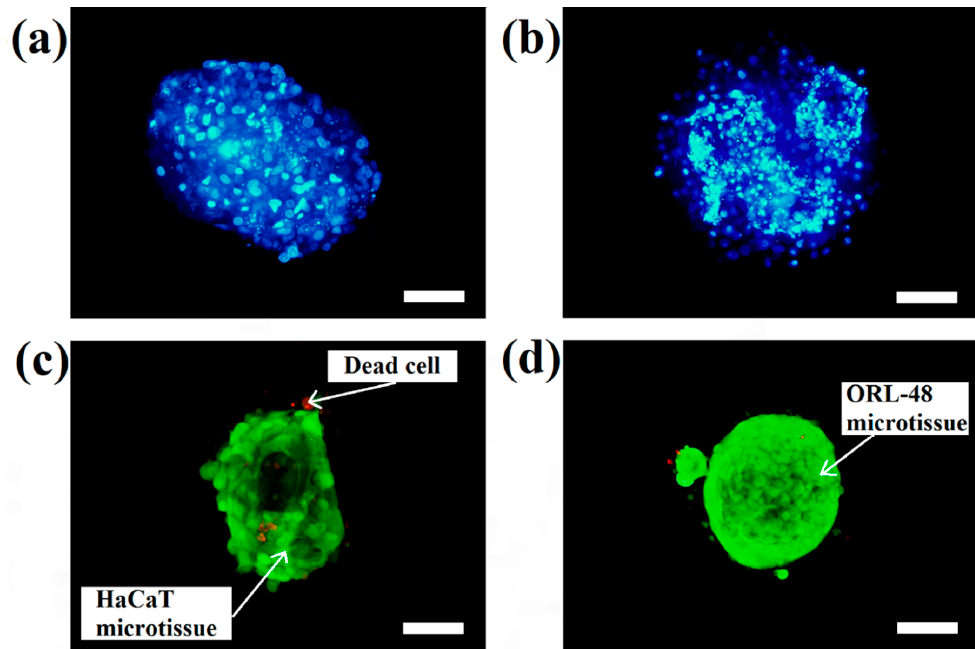
Figure 4. DAPI (4 ′ , 6-diamidino-2-phenylindole dihydrochloride) staining of cells in the microtissues of ( a ) HaCaT and ( b ) ORL-48 after 16 days of culture at 100× magnification (Scale bar: 100 μ m). Live and dead staining fluorescence microscopic images of ( c ) HaCaT and ( d ) ORL-48 microtissues after 16 days of culture at 100× magnification (Scale bar: 100 μ m).